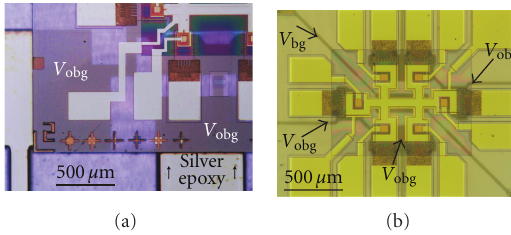
Figure 5: Composite IR and visible photographs (a) Backgated sample mounted on host substrate with etched channels indicated to contact backgate with silver epoxy. (b) Thinned sample with outer backgates ( V obg ) and central backgate ( V bg ) visible.